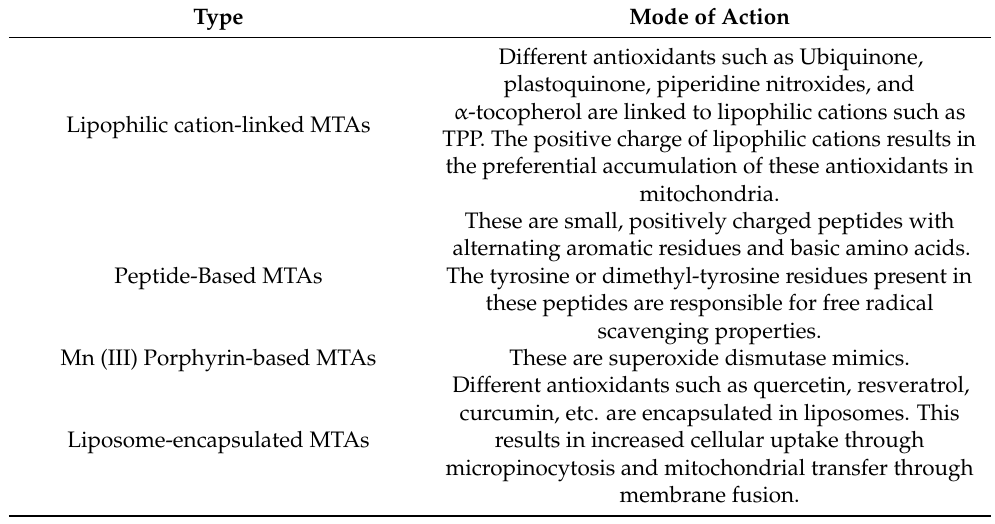
Table 1. Mitochondria-targeted antioxidants and their mode of